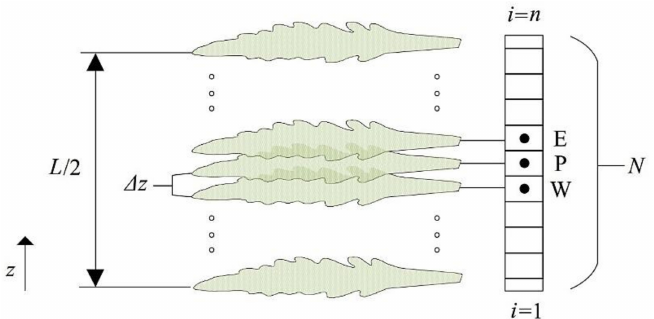
Figure 2. One-dimensional computational domain of a single lavender